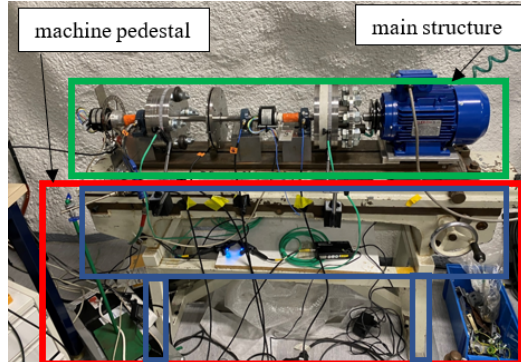
Figure 3. Experimental setup full view.